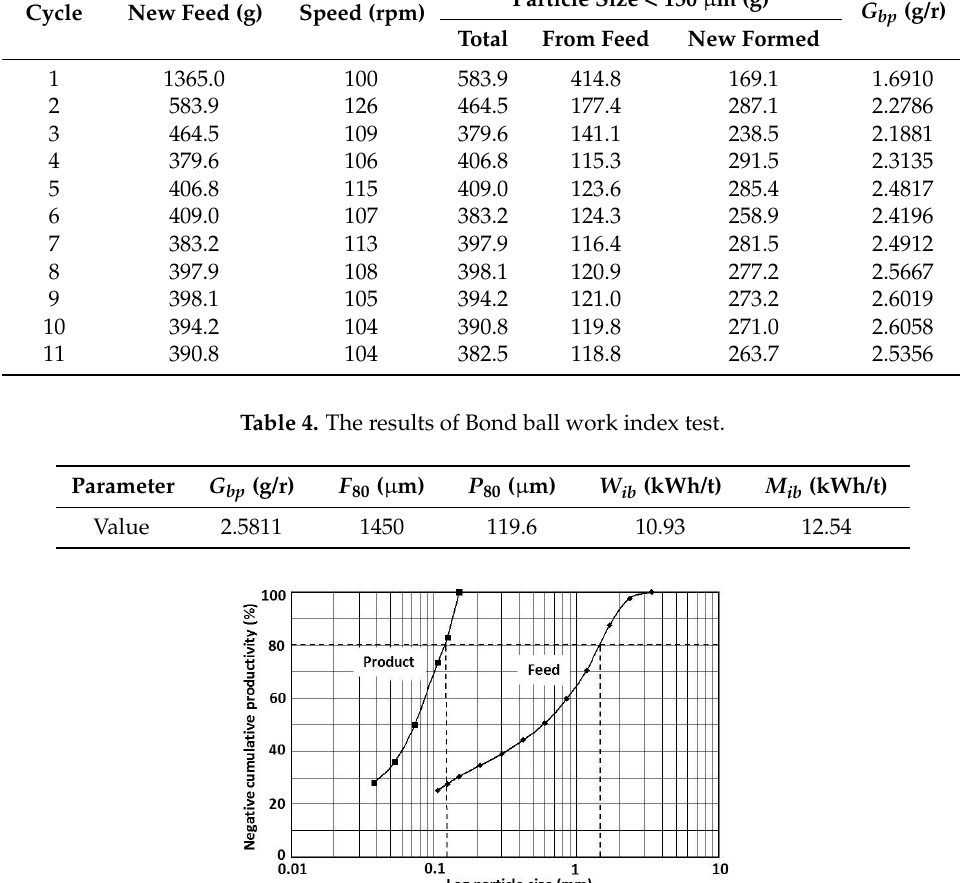
Table 3. Bond ball work index test.